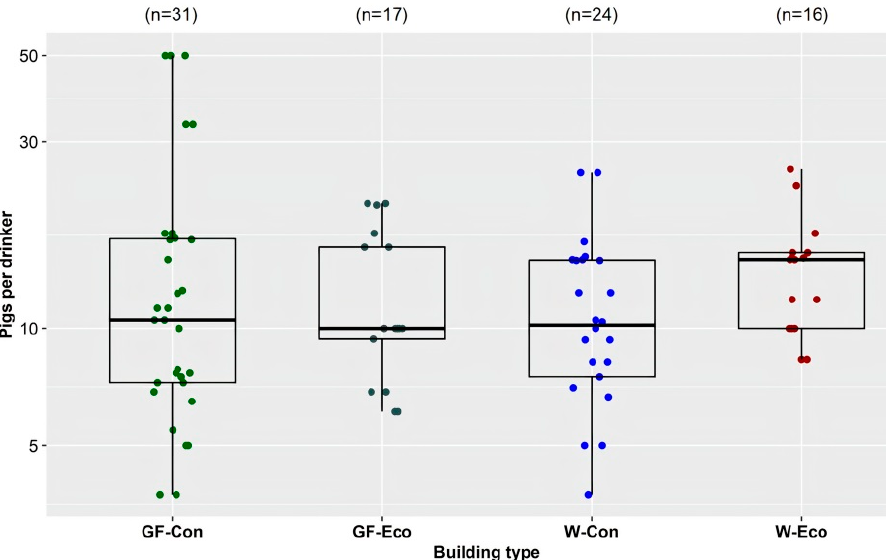
Figure 4. Pigs per drinker by building type (GF-Con: Q1: 7.25, Median: 10.5, Mean: 15.4, Q3: 16.9; GF-Eco: Q1: 9.4, Median: 10, Mean: 12.2, Q3: 16.1; W-Con: Q1: 7.5, Median: 10.2, Mean: 11.4, Q3: 15; W-Eco: Q1: 10, Median: 15, Mean: 14.3, Q3: 15.6). GF-Con = conventional grower/finisher buildings (solid/slatted/mesh floored pens), GF-Eco = grower/finisher eco-shelters (straw-floored pens), W-Con = conventional weaner buildings (solid/slatted/mesh floored pens), W-Eco = weaner eco-shelters (straw-floored pens).